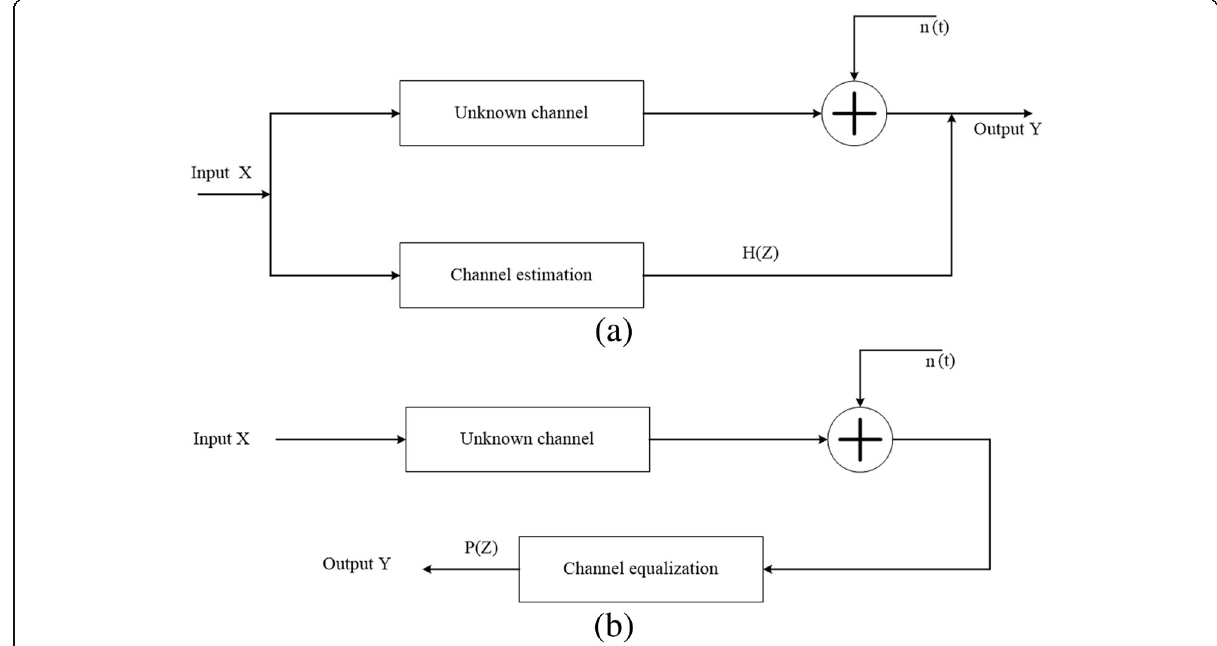
Fig. 4 The comparison between channel estimation and equalization: a estimation and b equalization